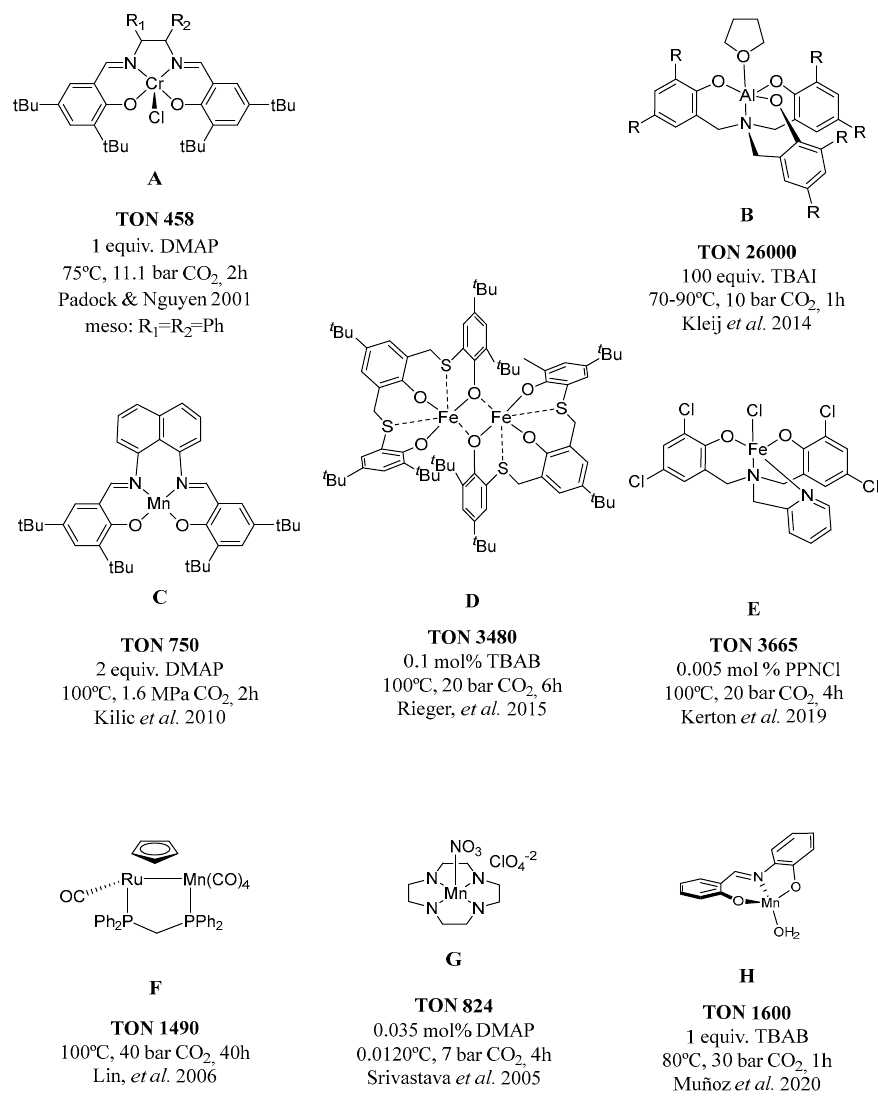
Figure 1. Selected catalytic systems developed for the synthesis of cyclic organic carbonates from CO 2 and epoxides.